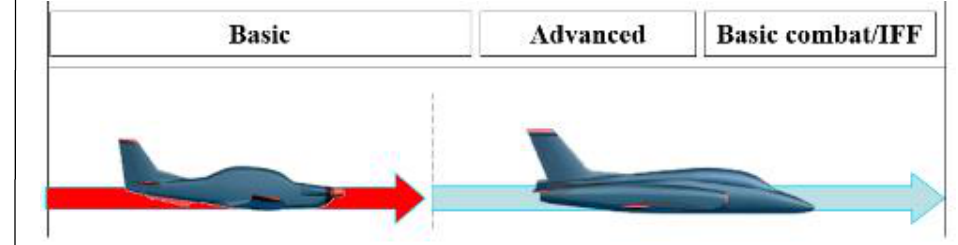
Figure 1 – Basic flight training on the Lasta precedes the training on the G-4 Рис. 1 – Основная летная подготовка на самолете „Ласта“, предшествующая учениям на „Г-4“.